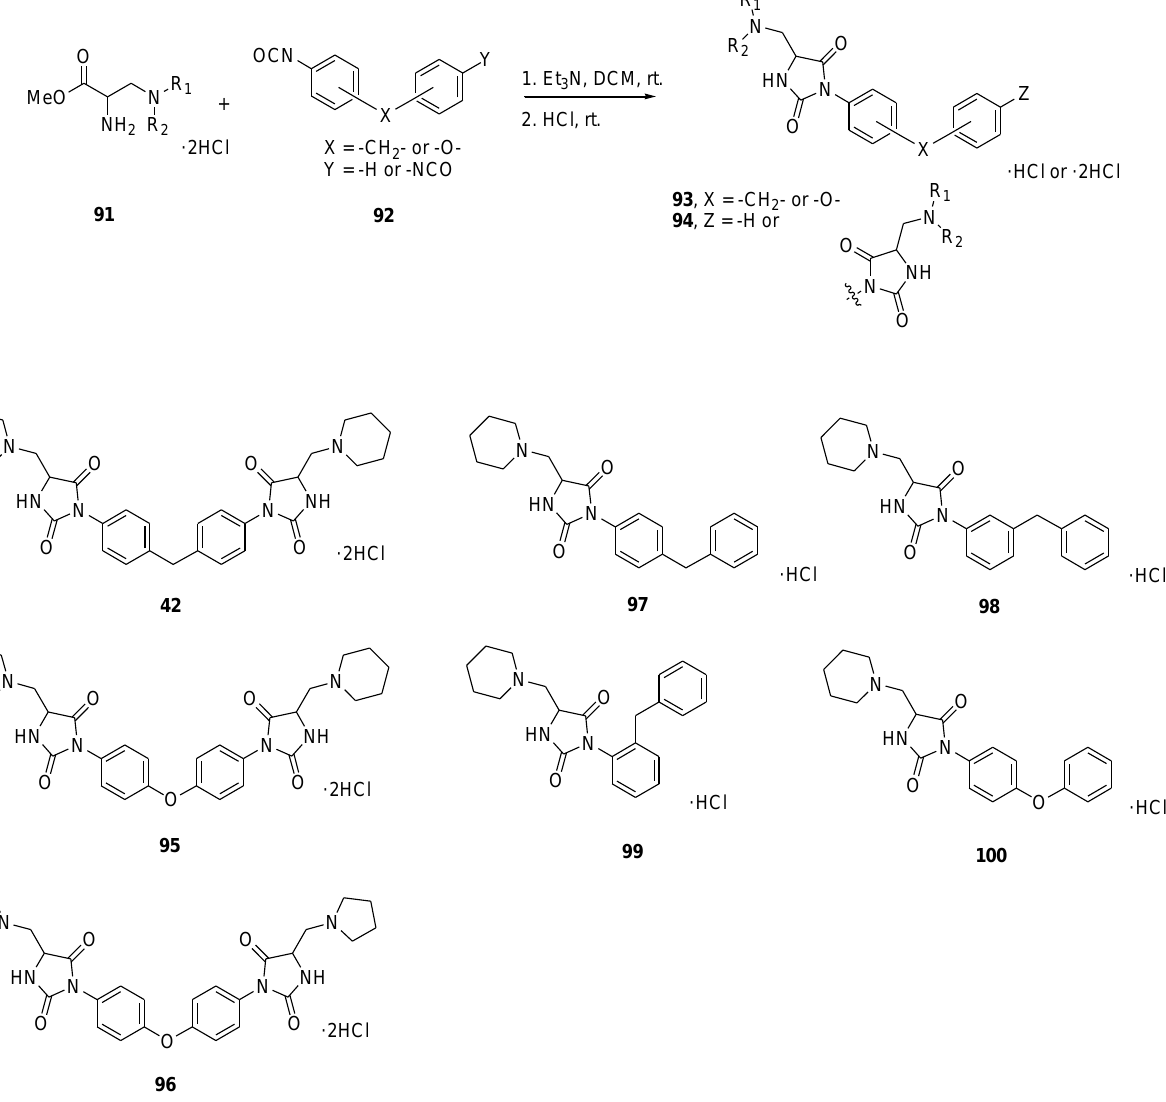
Figure 19. Reaction scheme of the synthesis of the hydantoin motif and representation of the various hydantoin derivatives.